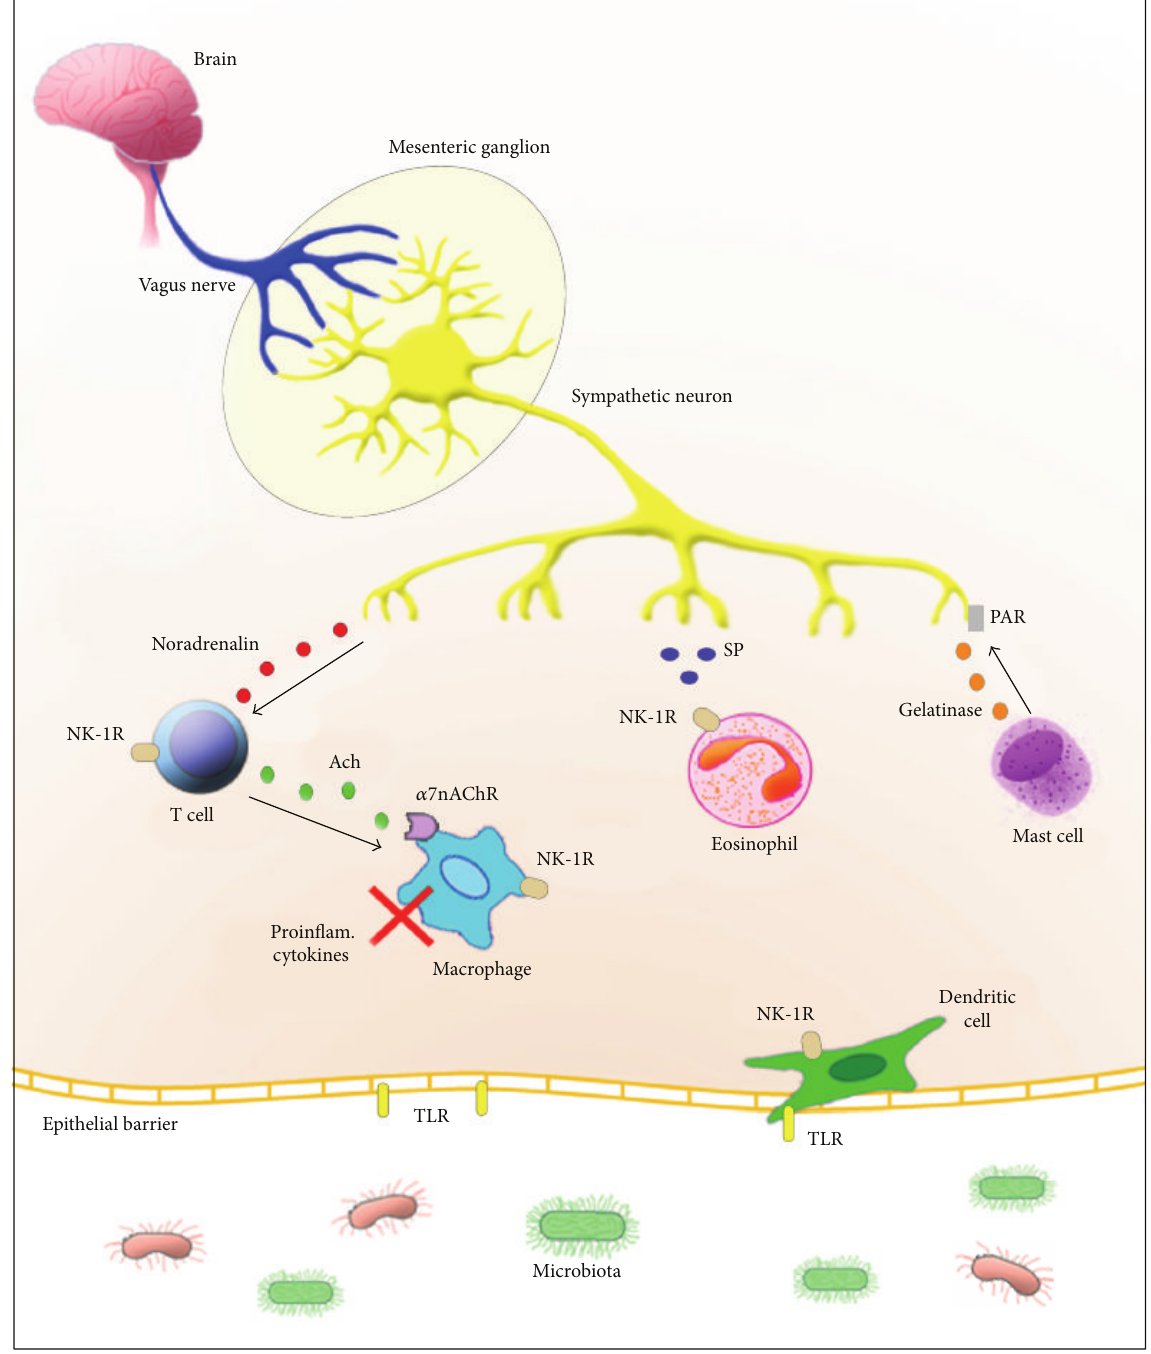
Figure 2: Interaction between the enteric neuron system (ENS) and mucosal immune cells. Upon vagus nerve stimulation, the sympathetic innervation secretes neurotransmitters that can modulate immune cells and the inflammatory response. The intestinal microbiota also participates in the inflammatory response fine-tuning the interaction between the ENS and mucosal immune cells.